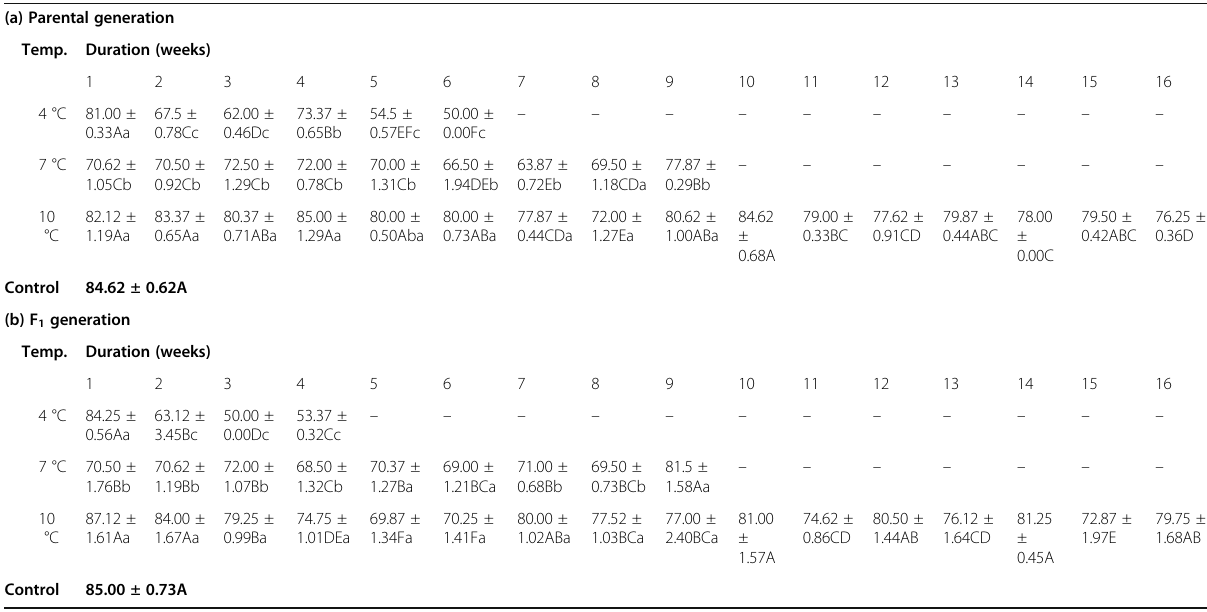
Table 4 Percentages of Trichogrammatoidea bactrae females in parental and F 1 generations during storage of parasitoid larvae at different low temperatures (a) Parental generation Temp. Duration (weeks)